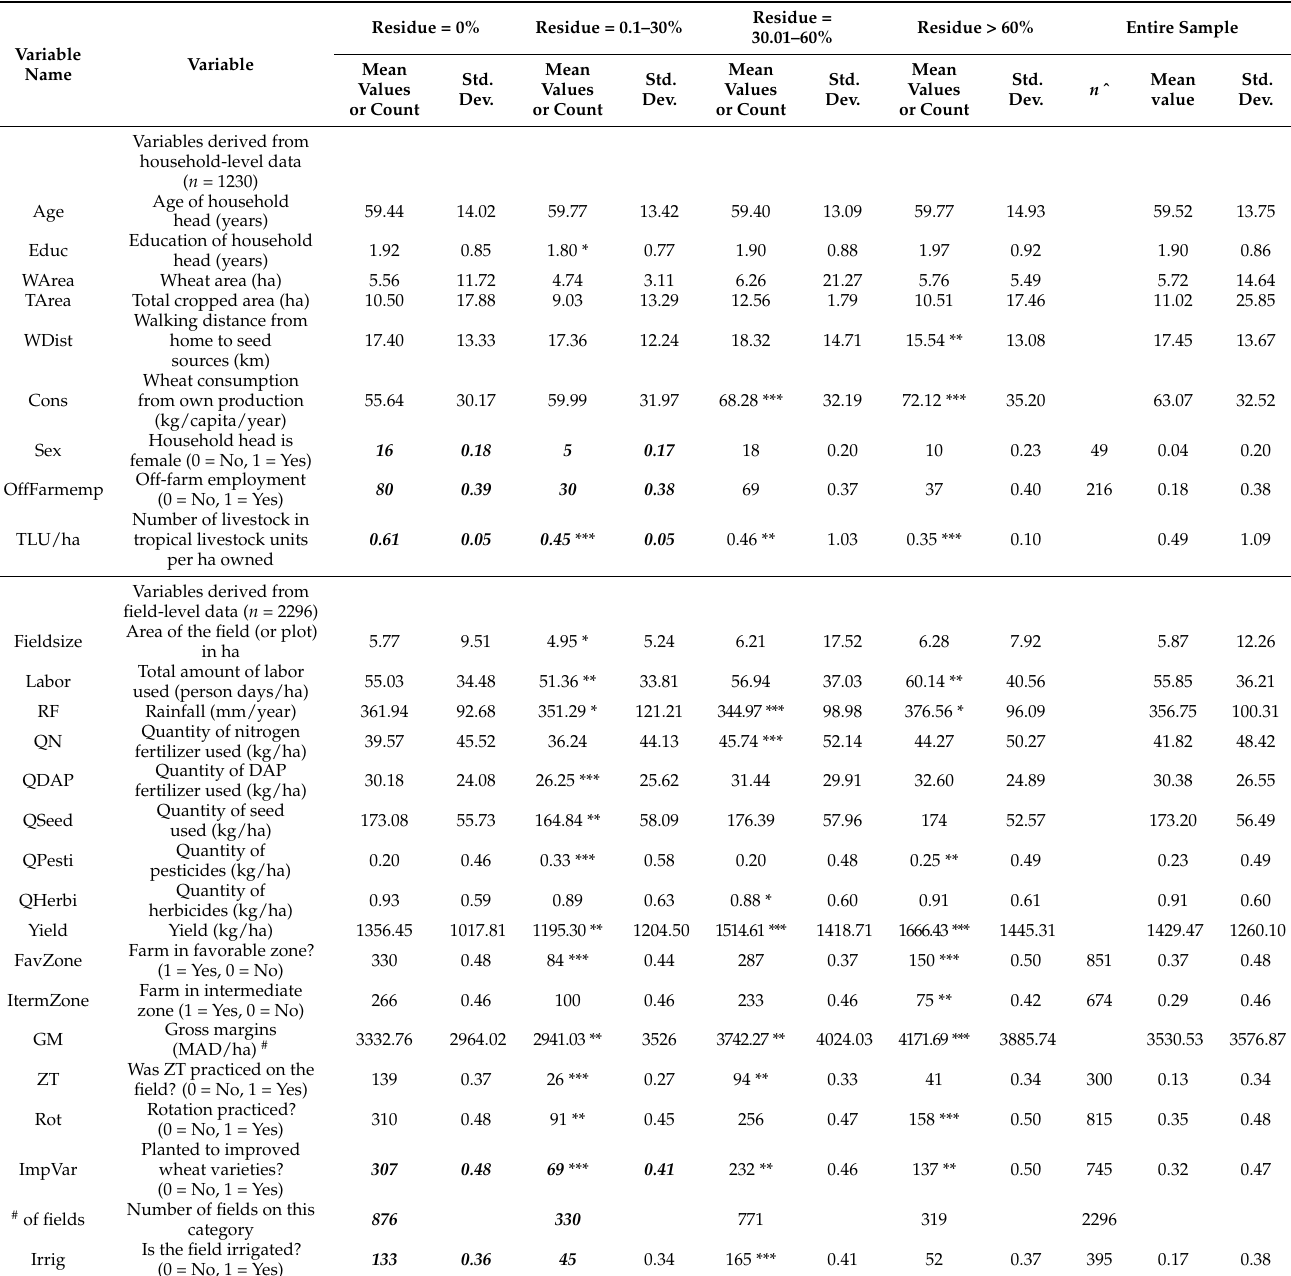
Table 2. Summary statistics for selected